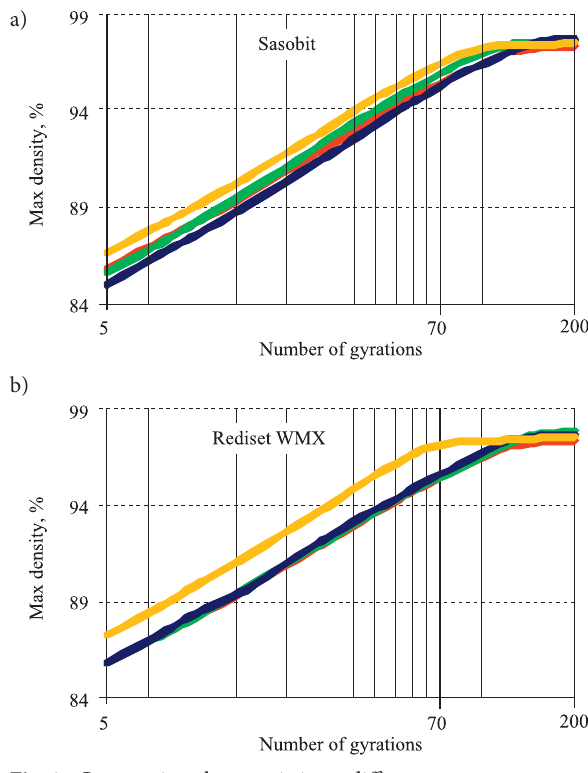
Fig. 9. Compaction characteristics at different temperatures: